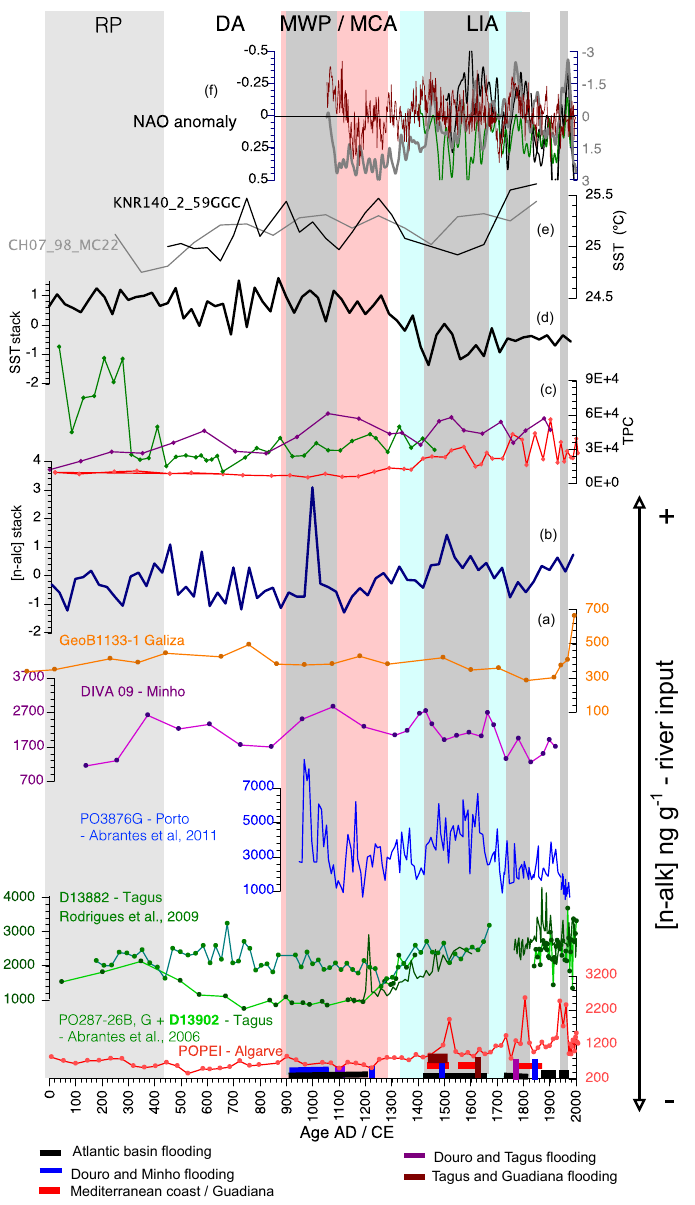
Figure 3. (a) : [ n -alk] (ngg − 1 ) variability over the last 2 millennia and the five Iberian Margin sites; colors are as in Fig. 3. (b) : The [ n -alk] stack anomaly. (c) : Total pollen concentration (TPC, no pollen grainscm − 3 sediment). (d) : SST stack anomaly. (e) : SST NW Atlantic cores KNR140-2-59GGC and CH07-98-MC22 (Saenger et al., 2011). (f) : NAO index (black line – Luterbacher et al., 2002; green line – Cook et al., 2002; gray line – Trouet et al., 2009; brown line – Ortega et al., 2015). Dark gray bands mark the periods of Atlantic flooding as listed in Table 3. Light gray band marks the RP; the pink band marks the MCA; the blue band marks the